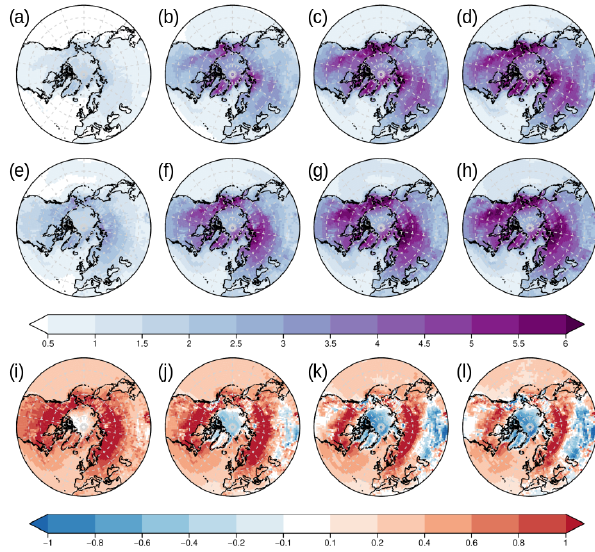
Figure A1. Ensemble standard deviation of 2m temperature for week 1 to week 4 (a–d) CNRM and (e–h) ECMWF and week 1 to week 4 standard deviation differences “ECMWF minus CNRM” (i– l) . Differences not significant at the 95% confidence level have been set to